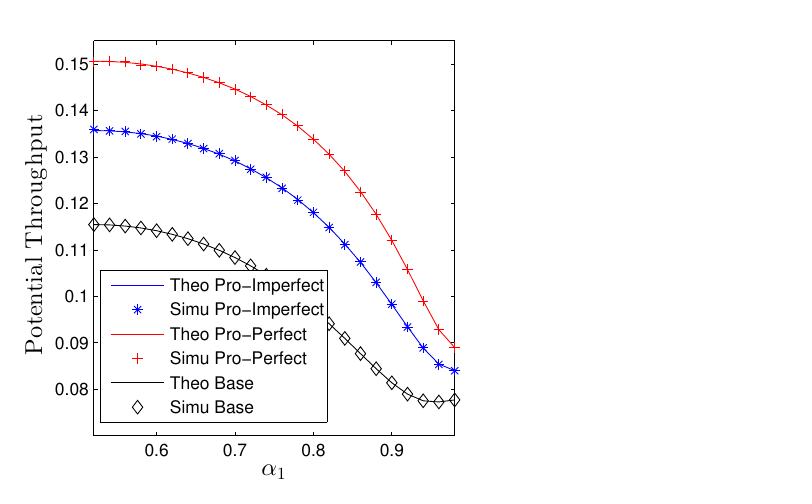
Figure 9. Potential throughput vs. α 1 under all schemes. Solid lines are plotted by employing (13) while markers are Monte Carlo